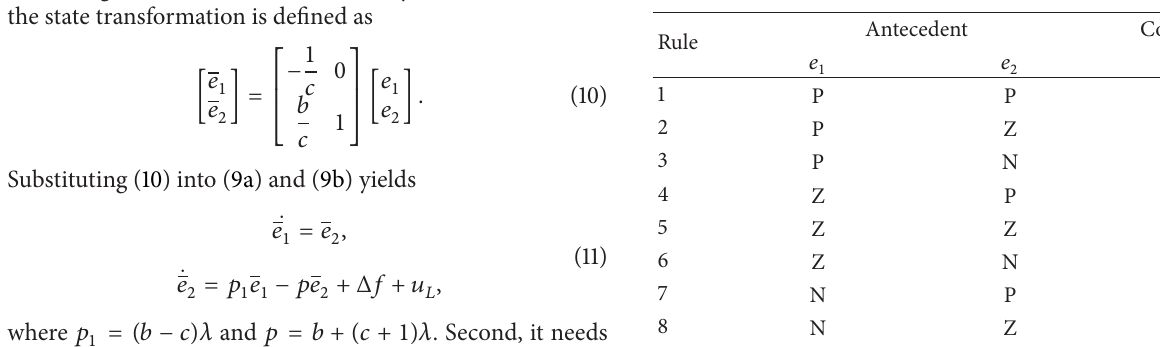
Table 3: Rule table of